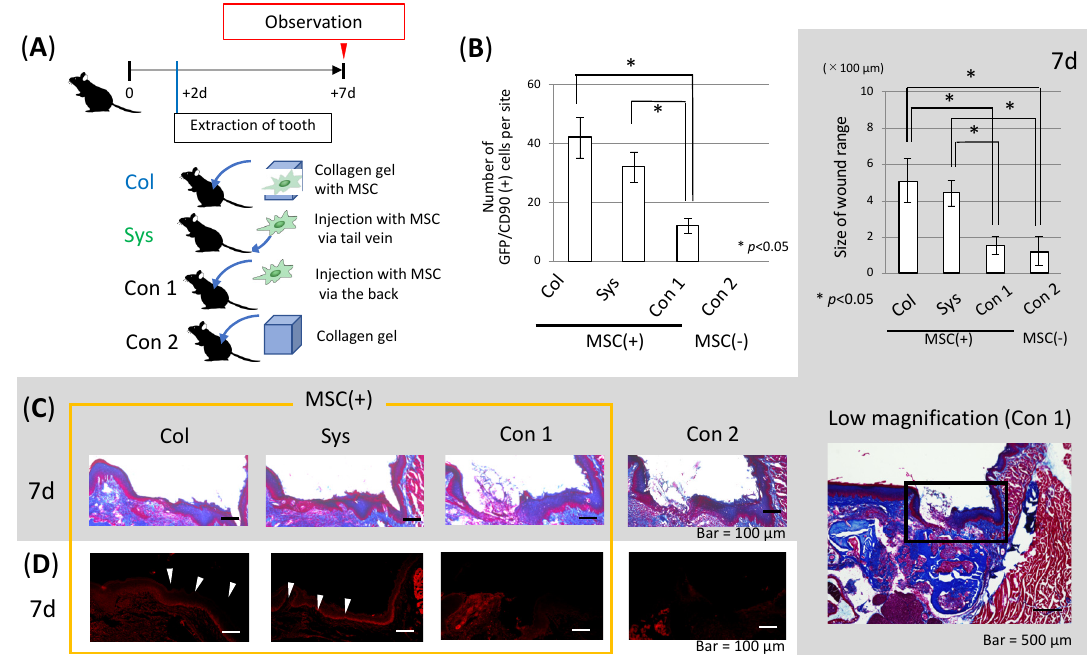
Figure 5. Effect of MSCs from collagen gel for tooth extraction. ( A ) Experimental protocol for in vivo experiments. ( B ) At 7 days after MSC administration, numbers of accumulated MSCs around the tooth extraction socket. MSCs injected via the tail vein and MSCs from collagen gel were observed as many GFP/CD90 double ‐ positive cells around the socket after extraction by immunofluorescence staining. Injected MSCs accumulated similarly to scaffold MSCs. ( C ) Extraction socket healing. The scaffold MSC group and the injected MSC group showed good mucosal healing at 7 days. Scale bars, 100 µ m. * p < 0.05. ( D ) localization of Ln-332. Laminin-332 was observed as a line on connective tissue in both the systemic injection and collagen scaffold groups (white arrowheads).